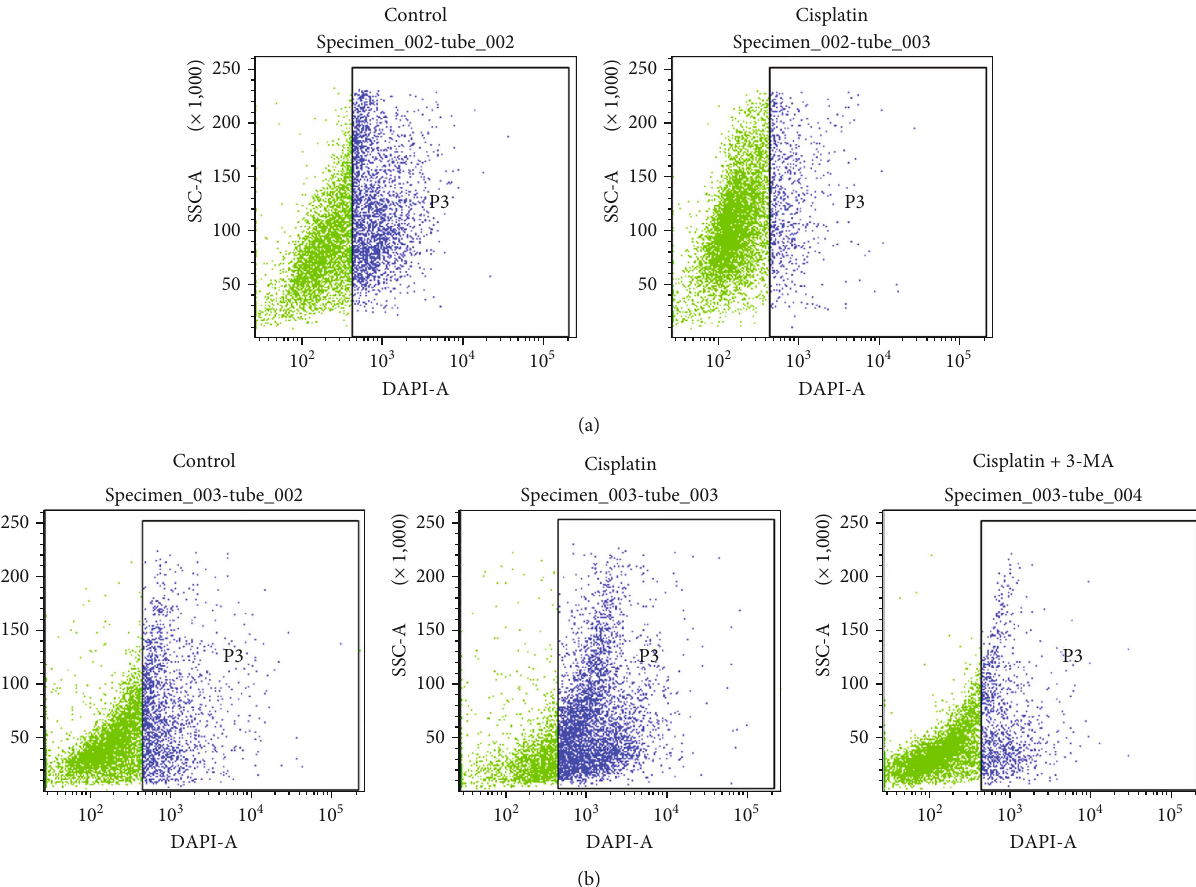
Figure 4: Autophagy analysis of BIU-87 bladder cancer cells. (a) Under normoxia, fl ow cytometry revealed that autophagy was not activated in the cisplatin group (8%) compared with the control group (27.7%). (b) Under hypoxia, fl ow cytometry showed that autophagy was 19.4% in the control group, signi fi cantly increased in the cisplatin group (48.1%) and downregulated after incubation with autophagy inhibitor